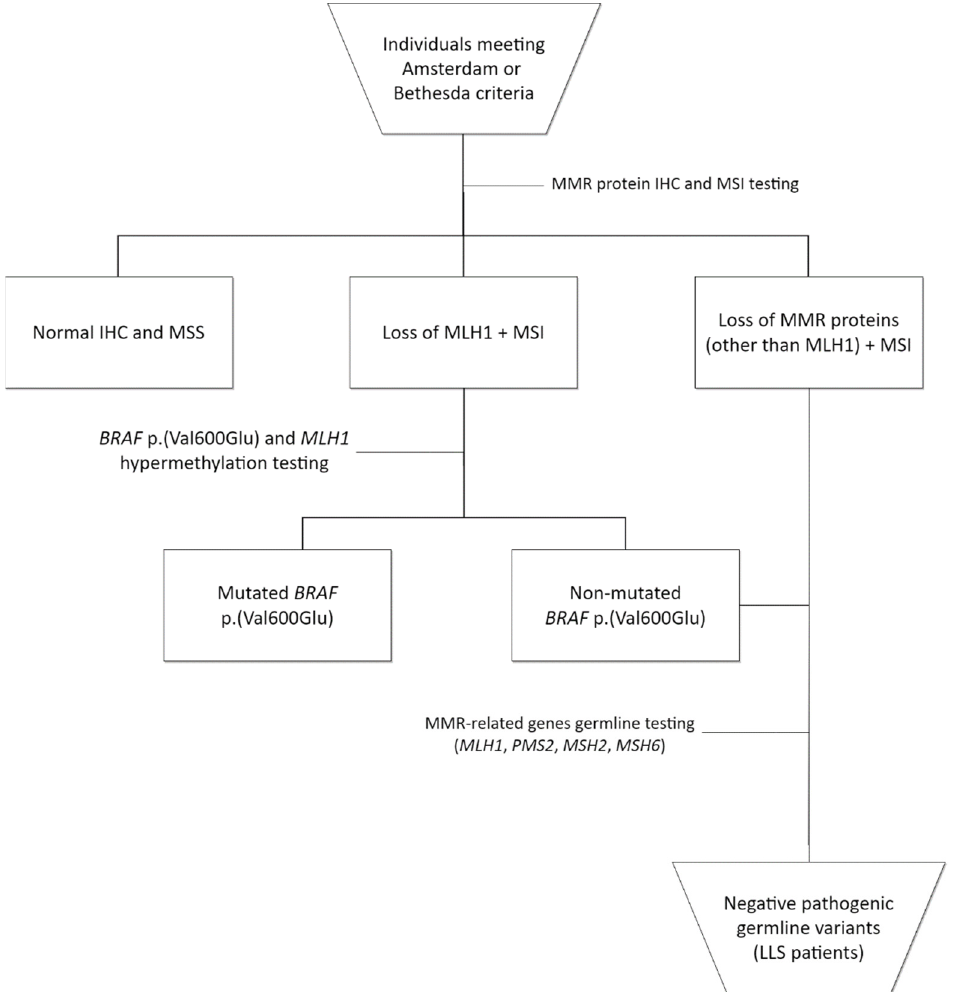
Figure 1. Flowchart of Lynch-like syndrome (LLS) patients’ identification and inclusion. IHC: immunohistochemistry; MSI: microsatellite instability.